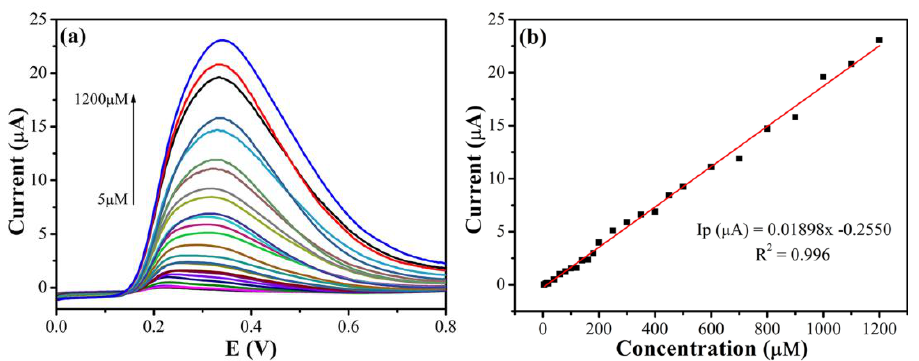
Figure 9. ( a ) DPV responses of Bi 2 S 3 /rGO-3/GCE in the presence of AA in concentrations ranging from 5 µM to 1200 µM; ( b )The plot of anodic peak current versus different concentration values. Table 1. The performance in AA detection using Bi 2 S 3 /rGO-3/GCE, in comparison with other reported materials.